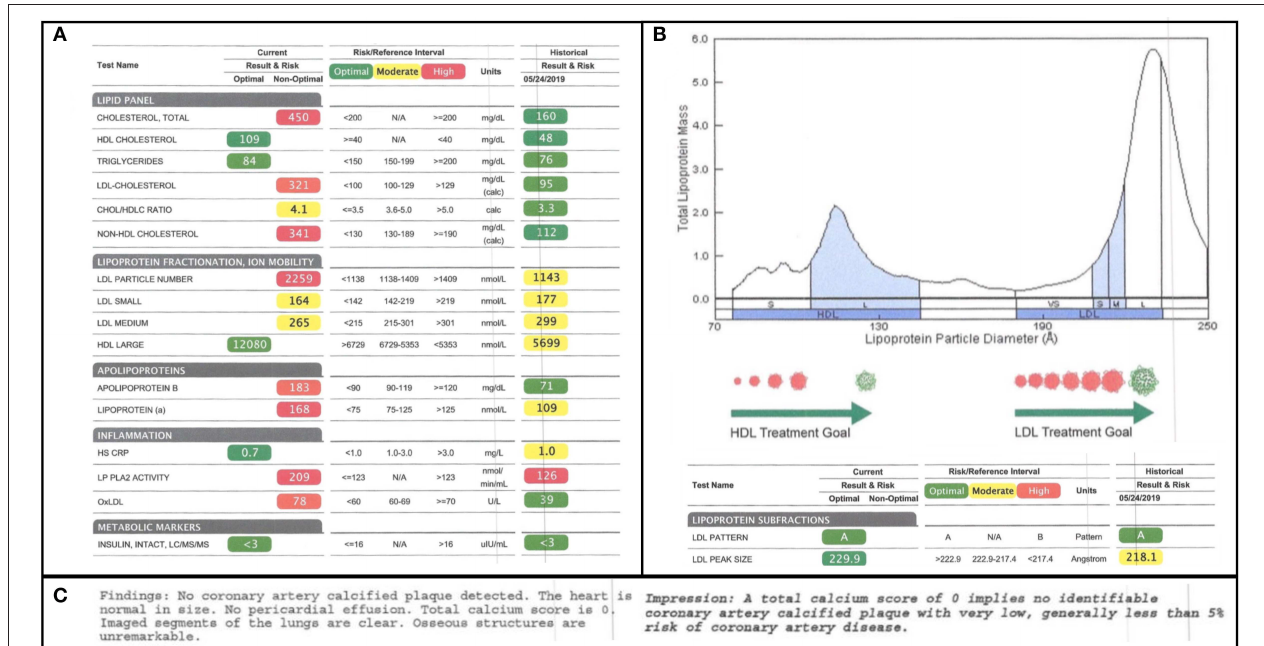
FIGURE 1 | Lipid Subfractionation. (A) The subject’s baseline lipids, prior to starting his ketogenic diet, are shown on the right. His 7-month follow-up lipids are shown on the left. Green, yellow, and red imply optimal, medium, and high cardiovascular risk, respectively, based on standard reference ranges of isolated variables. (B) The subject’s lipoprotein size distribution is characterized by a multimodal distribution of HDL, with the greatest peak being in large HDL, and a strong bias in LDL away from atherogenic, small LDL and toward large LDL. (C) Results of the subject’s coronary artery calcium scan, performed at the time of the 7-month follow-up, indicating little-to-no calcified plaque